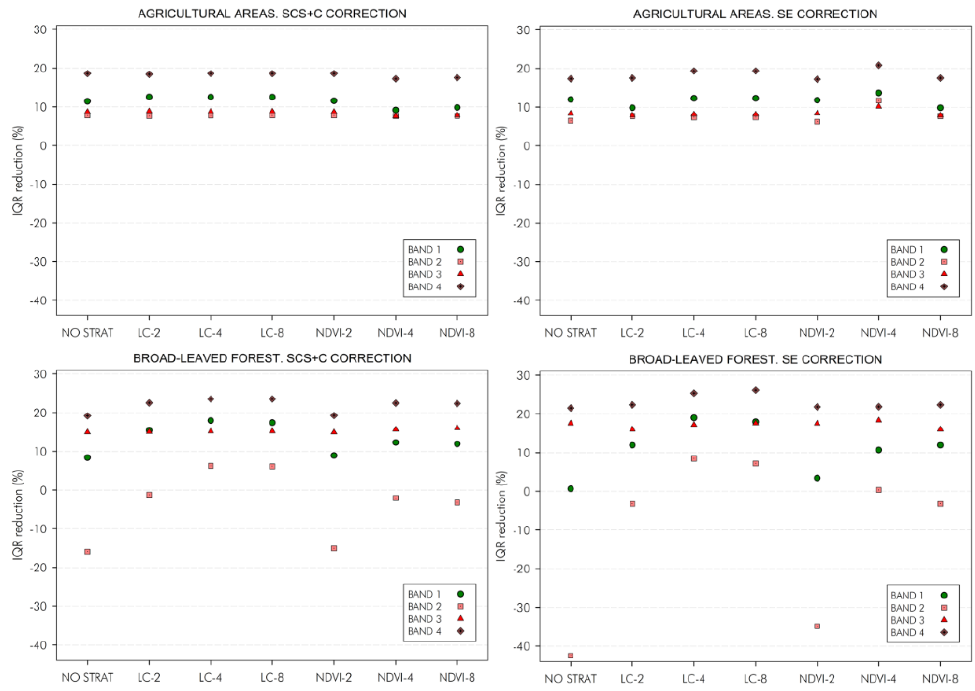
Figure 10. Intraclass IQR reduction of broad-leaved forest and agricultural areas for each spectral band.